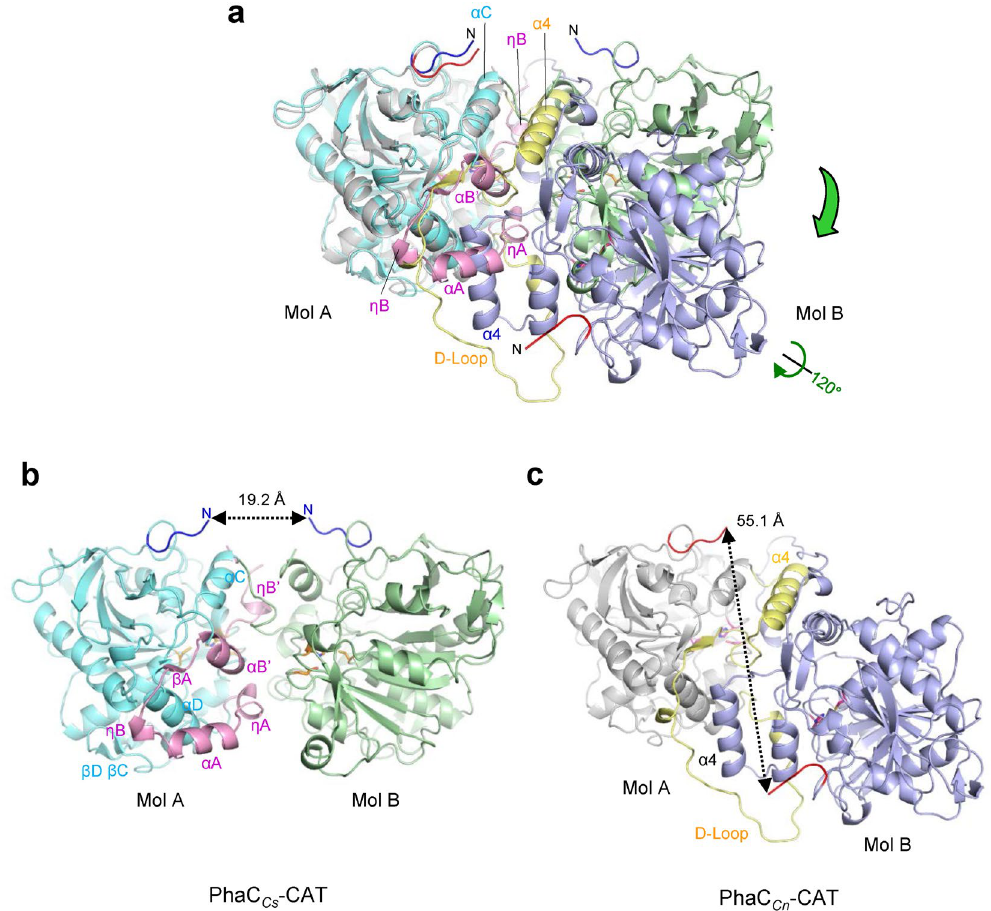
Figure 6. Conformational changes in the CAP subdomain induce dimer organization as revealed by comparison of PhaC Cs -CAT and PhaC Cn -CAT dimers. ( a ) Overlay of the PhaC Cs -CAT dimer (cyan and green) on the PhaC Cn -CAT dimer (gray and purple). One protomer (cyan) of the PhaC Cs -CAT dimer is superimposed on one protomer (gray) of the PhaC Cn -CAT dimer. The distance between the catalytic cysteine residues in the PhaC Cs -CAT dimer is 28.1 Å, while that in the PhaC Cn -CAT dimer is 33.3 Å. ( b ) The PhaC Cs -CAT dimer. The distance between the N-termini is 19.2 Å. ( c ) The PhaC Cn -CAT dimer with mol A in the same orientation as mol A in the PhaC Cs -CAT dimer as in ( b ). The dimer interface is reorganized by refolding/unfolding of the LID region with accompanying rotation of one protomer. The distance between the N-termini is 55.1